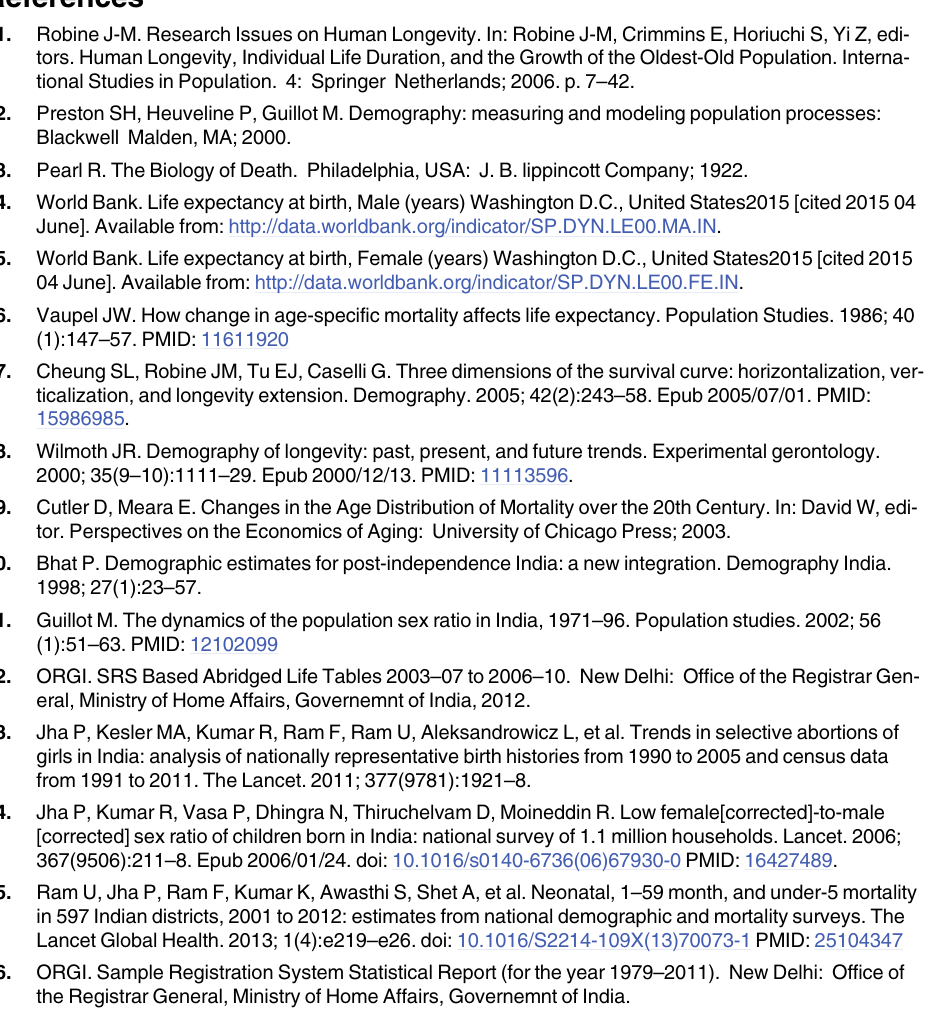
S4 Table. Components (in %) of change in gap between life expectancies at ages zero and five, India and States, 1981 – 09. Arranged in descending order of “ Below age five ” component in the period 2005 –